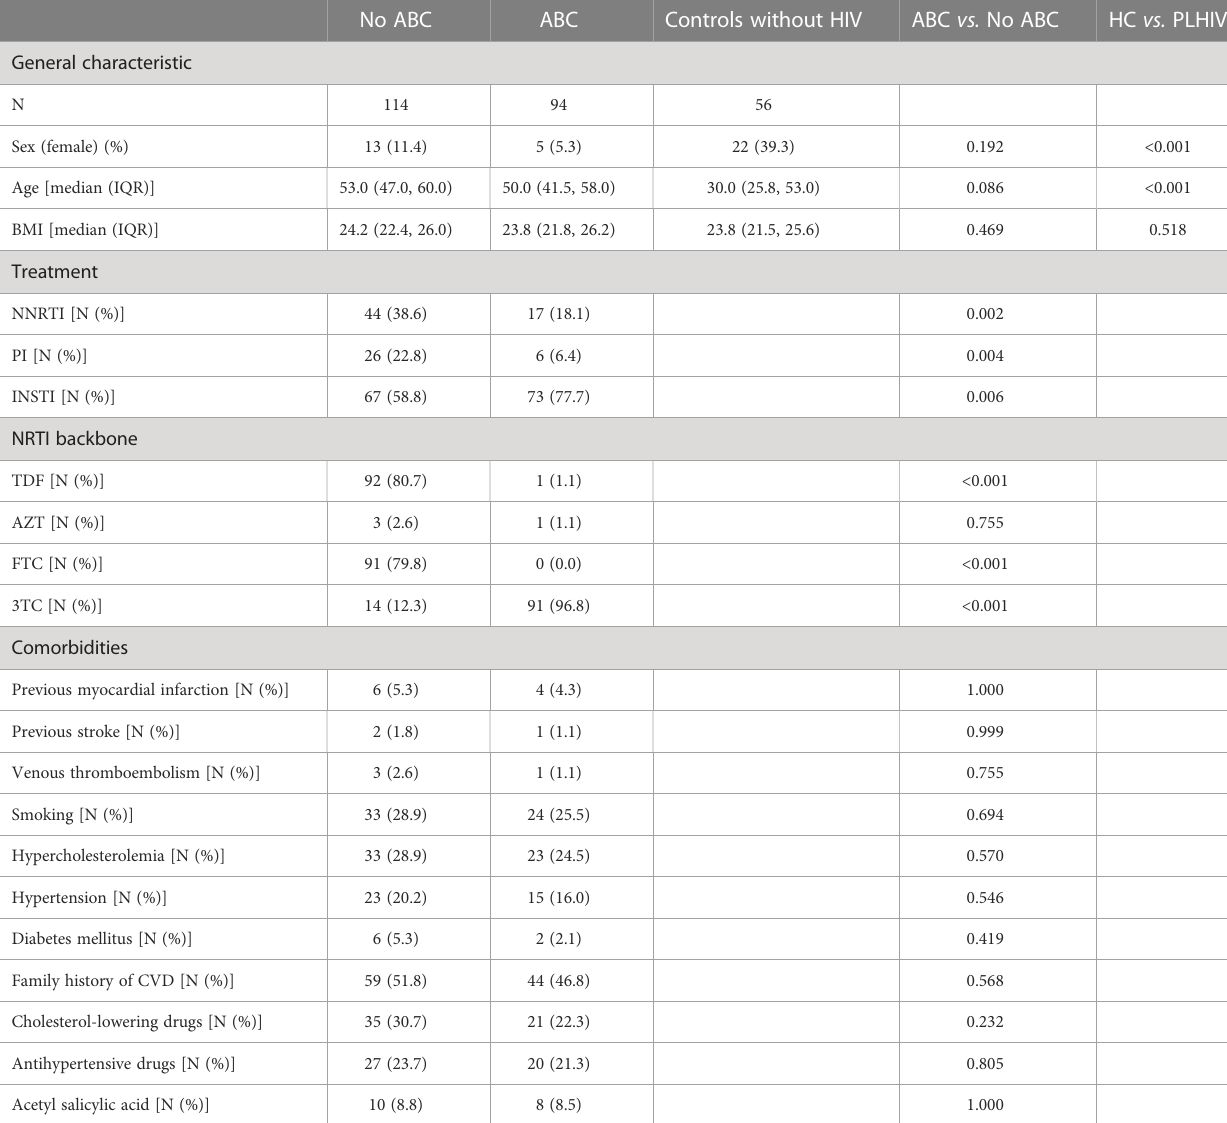
Data are shown as median and interquartile range, or number and percentage. Statistical differences between groups were analyzed by the Mann-Whitney test, or the Chi-square test, depending on variable type. This cohort was previously described in relation to D-dimer and thrombin generation measurements (17). NNRTI, non-nucleoside reverse transcriptase inhibitor; PI, protease inhibitor; INSTI, integrase inhibitor; NRTI, nucleoside/nucleotide reverse transcriptase inhibitor; TDF, tenofovir disoproxil fumarate; AZT, zidovudine; FTC, emtricitabine; 3TC, (Figure 4B). The increase in prothrombin conversion in PLHIV on ABC-based treatment resulted in a signi fi cantly higher amount of thrombin-antithrombin (T-AT) complexes formed PLHIV on ABC-based treatment (Figure 4C; 958 nM ± 208 nM vs. 858 nM ± 180 nM; p=0.0003), which is a main inhibitor of thrombin. The formation of thrombin- a 2 -macroglobulin (T- a 2 M) complexes did not differ between participants with ABC-based and non-ABC- based treatments (Figure 4D).